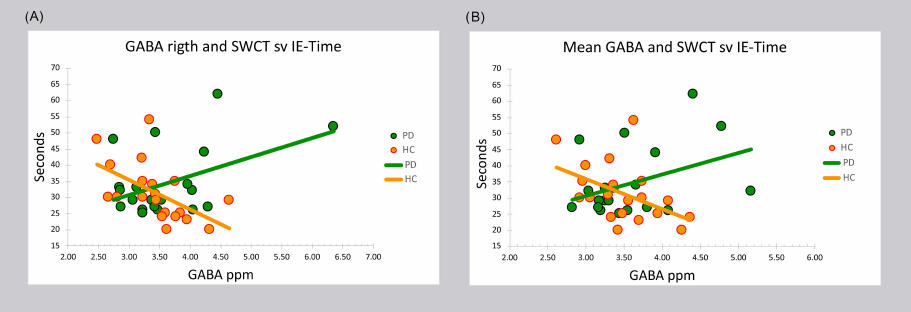
Figure 2. Bivariate scattergrams of the differential relationship in experimental groups between cerebellar gamma-aminobutyric acid (GABA) and cognitive interference. Legend: ( A ) right and ( B ) left and right mean values of GABA cerebellar concentration and response inhibition performance in patients diagnosed with Parkinson Disease (PD) and Healthy Comparators (HC), as measured through the time (in seconds) Interference Effect of the Stroop Word-Color Test short version (SWCT sv IE-Time). ppm: parts per